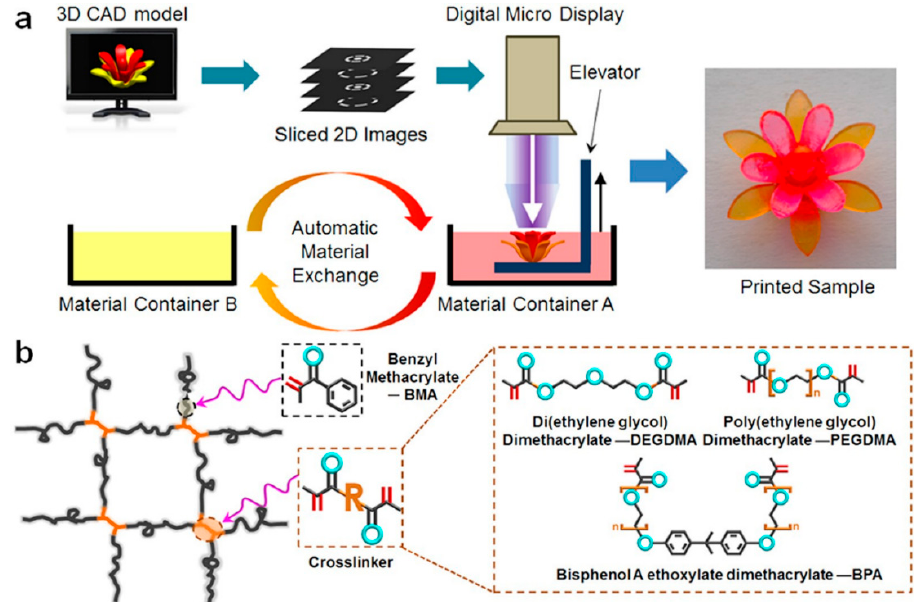
Figure 28. ( a ) Process working schematics for multi-material SLA printing using two different monomers and ( b ) the chemical structure developed by monomers via multi-material SLA printing. Reproduced from [61].